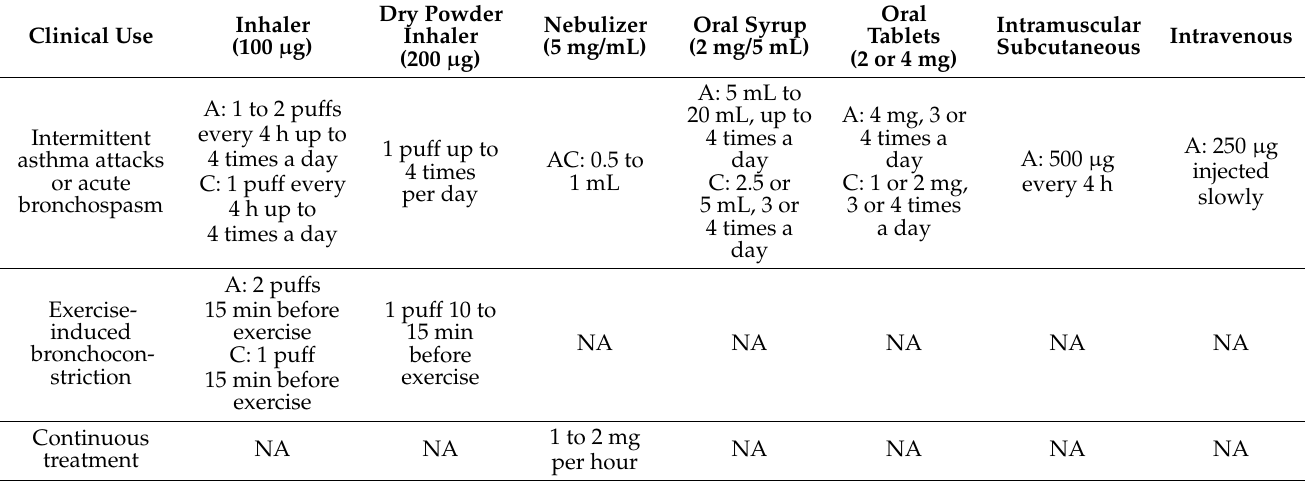
Table 2. Recommended dosages for salbutamol